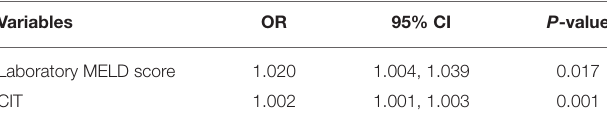
TABLE 3 | Multivariable analysis of characteristics between L-GrAFT 7 high and low risk